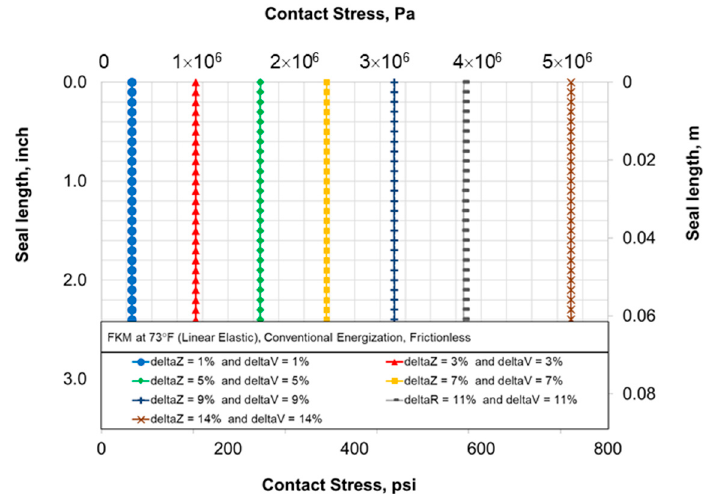
Figure 7. Contact stress profiles generated in conventional seal assembly at different volumetric compression.